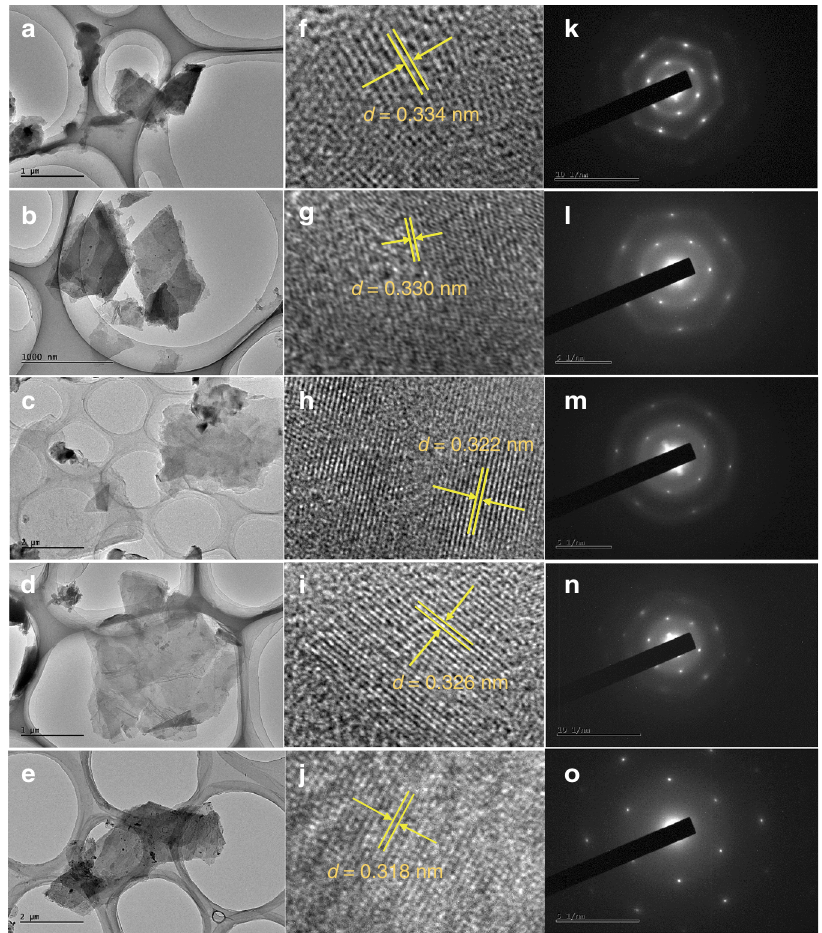
Fig. 2 Morphology and structural characterization of gersiloxenes. a – e Low-magni fi cation TEM images, f – j HRTEM micrograph, and k – o electron diffraction patterns of gersiloxenes sheets. a , f , k , x = 0.1; b , g , l , x = 0.3; c , h , m , x = 0.5; d , i , n , x = 0.7; e , j , o , x = 0.9. TEM transmission electron microscopy, HRTEM high-resolution transmission electron